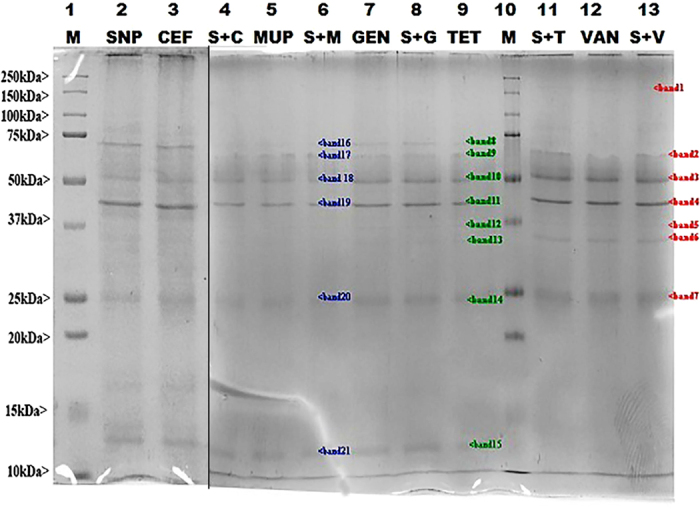
Membrane damage following intracellular protein caused by SNP, individual antibiotics and combination on P. aeruginosa cells visualized after SDS-PAGE and staining with coomassie.Lane 1, 10: Marker (M); Lane 2: SNP alone; Lane 3: CEF alone; Lane 4: SNP + CEF (S + C); Lane 5: MUP alone; Lane 6: SNP + MUP (S + M); Lane 7: GEN alone; Lane 8: SNP + GEN (S + G); Lane 9: TET alone; Lane 11: SNP + TET (S + T); Lane 12: VAN alone; Lane 13: SNP + VAN (S + V).